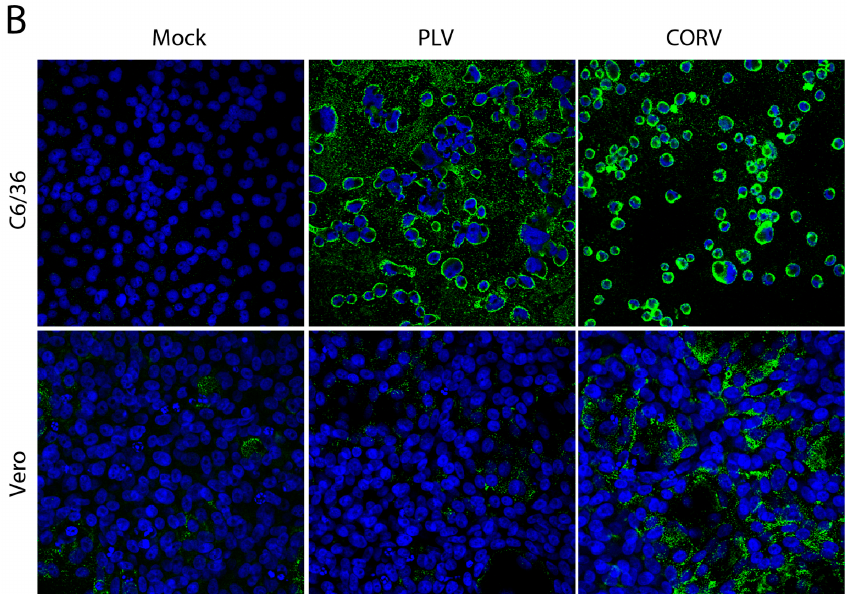
Figure 3. Vertebrate Cell Infection Assay. Mosquito (C6/36) and vertebrate (BHK, DF-1, Vero) cell monolayers were inoculated with PLV or CORV at an MOI of 1, or mock-infected and fixed 3 days post infect ( A ) or 9 days post infection ( B ). IFA analysis was performed with anti-dsRNA mAb 3G1 to detect replicating virus via dsRNA products [12]. Cell nuclei were stained with Hoechst 33342. Images were taken at ×40 magnification.